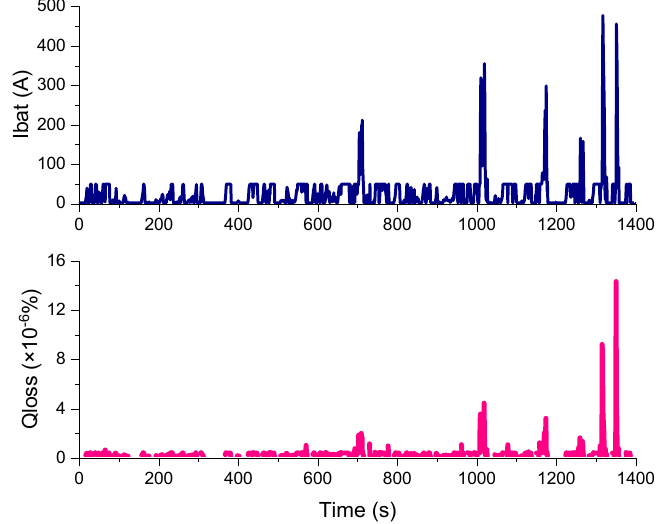
Figure 15. Battery current and battery degradation percentage at room temperature of 25 °C based on the rule strategy.